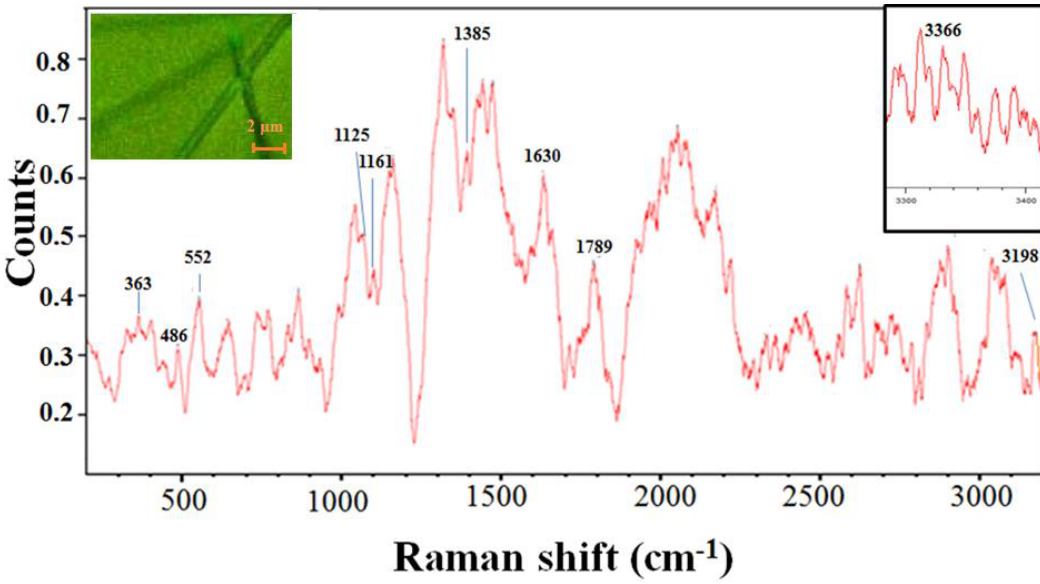
Figure 2. Raman spectrum and Raman image (left corner up inset) obtained by Raman spectroscopy measurements on the DS-1 electrospun polyimide fibers.